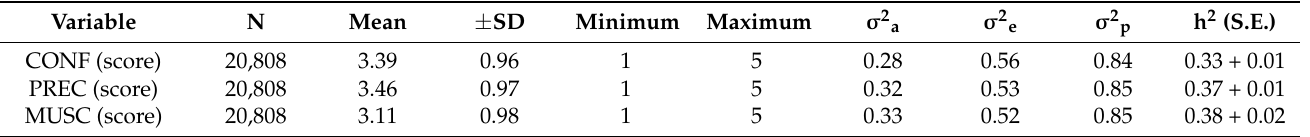
Table 1. Descriptive statistics, variance components and heritabilities for visual scores of conformation (CONF), precocity (PREC), and muscling (MUSC) in Nellore